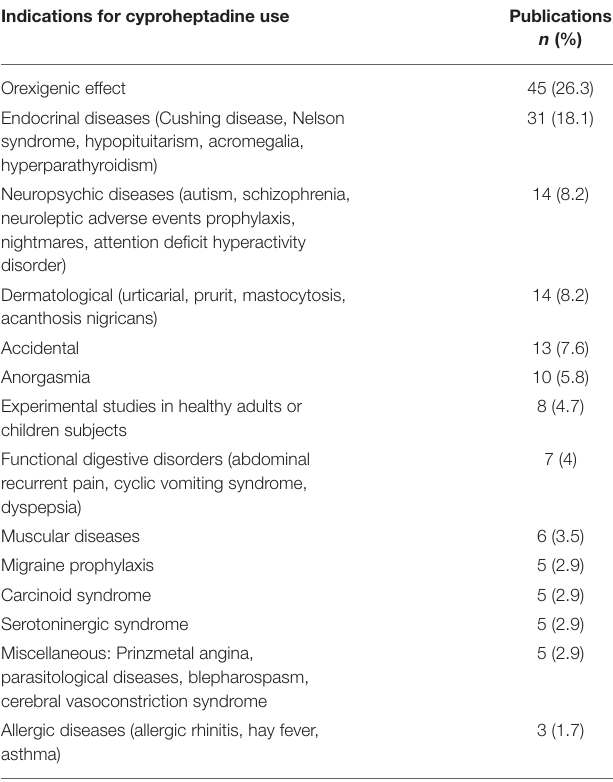
TABLE 3 | Indications for cyproheptadine use in the PRISMA-literature review. Indications for cyproheptadine